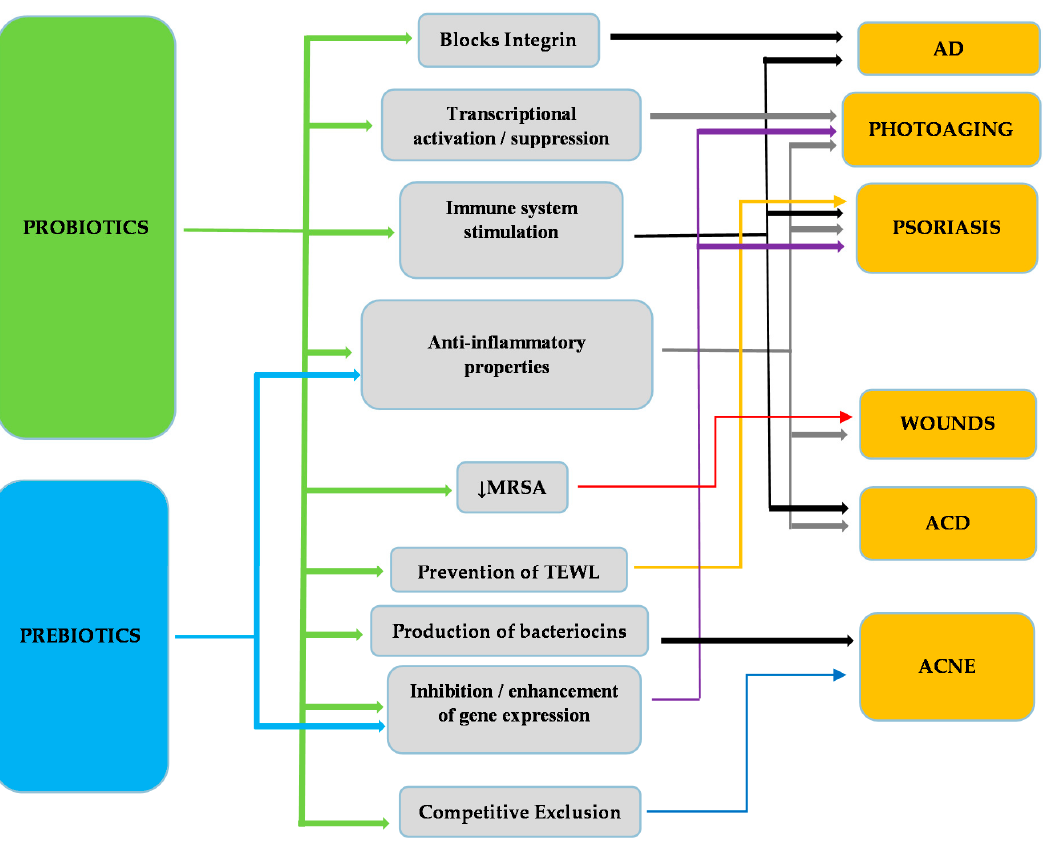
Figure 2. Linkage of various skin diseases with their respective mode of action through which pro- and prebiotics exert a beneficial effect. Methicilin Resistant Staphylococcus aureus (MRSA); Trans Epidermal Water Loss (TEWL).